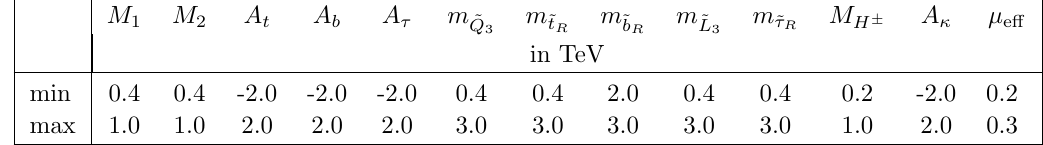
Table 1 . Scan ranges for the NMSSM scan, all parameters varied independently between the given minimum and maximum